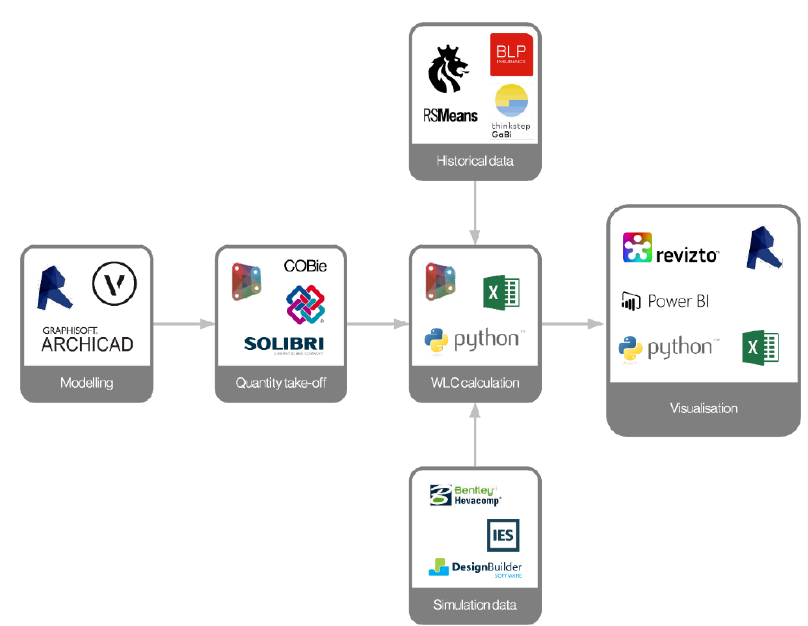
Figure 7. Semi-automated information flows between applications.